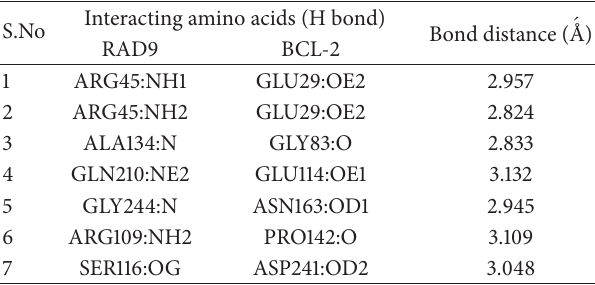
Table 2: Docking results of BCL-2 and RAD9